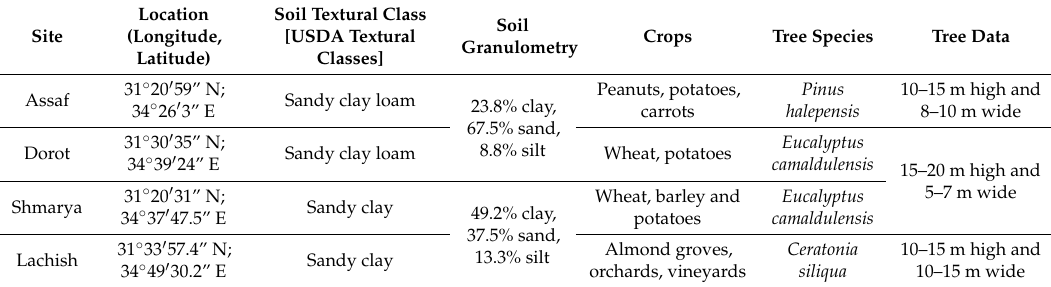
Table 1. Description of the study